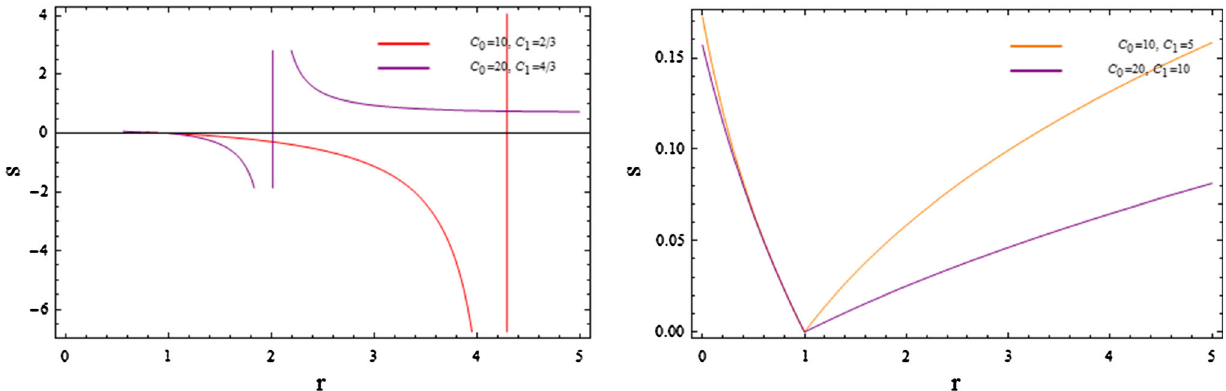
Fig. 2 The behavior of the deceleration parameter q eff ( t ) with various values of C 0 , C 1 at early time (left panel) and late time (right panel)